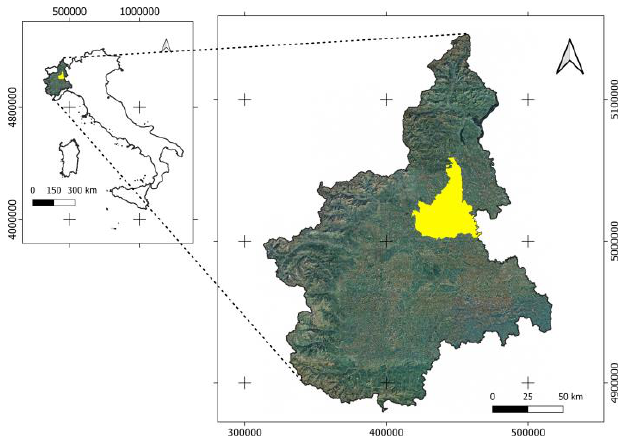
Figure 1. Study area (yellow) is located within the province of Vercelli in the Piemonte Region, NW Italy. (Reference system is WGS 84/UTM zone 32N, EPSG: 32632).